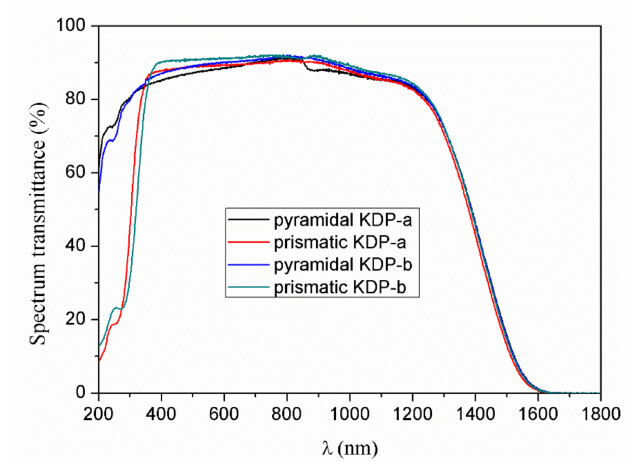
Figure 10. Optical transmittance of KDP crystals grown in [101]